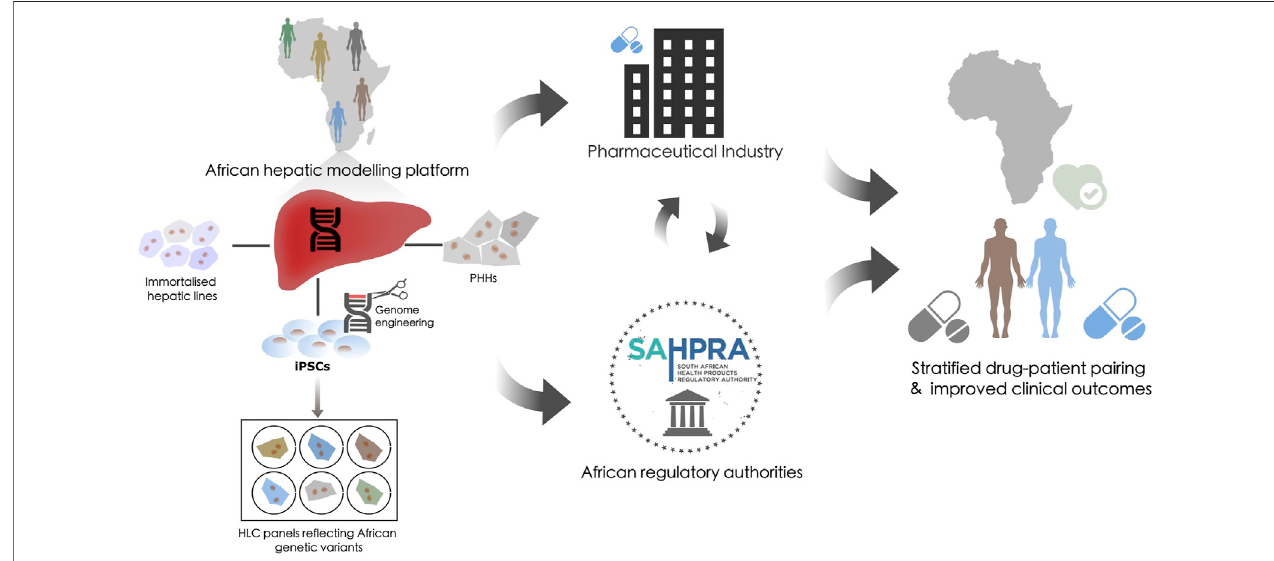
FIGURE 1 | The potential role of a hepatic modeling platform in guiding pharmacovigilance. Proposal for an integrative in vitro African pharmacovigilance platform thathousesvarioushepaticmodels.Suchamodelingplatformwouldutilizeimmortalizedhepaticlines,primaryhumanhepatocytes(PHH),andinducedpluripotentstem cells (iPSCs) from donors of African origin. iPSC could be genome engineered to generate panels of hepatocyte-like cells (HLCs) to speci fi cally validate African-relevant genetic variants against ef fi cacy/ADRs within an isogenic background. This platform would allow these models to be applied independently, interdependently, or sequentially to recapitulate and validate the xenobiotic metabolism of the liver across the genetic diversity of the African continent. This could then be used to inform decision-making in the global pharmaceutical industry and within the African regulatory landscape to stratify drug-patient pairing and improve clinical